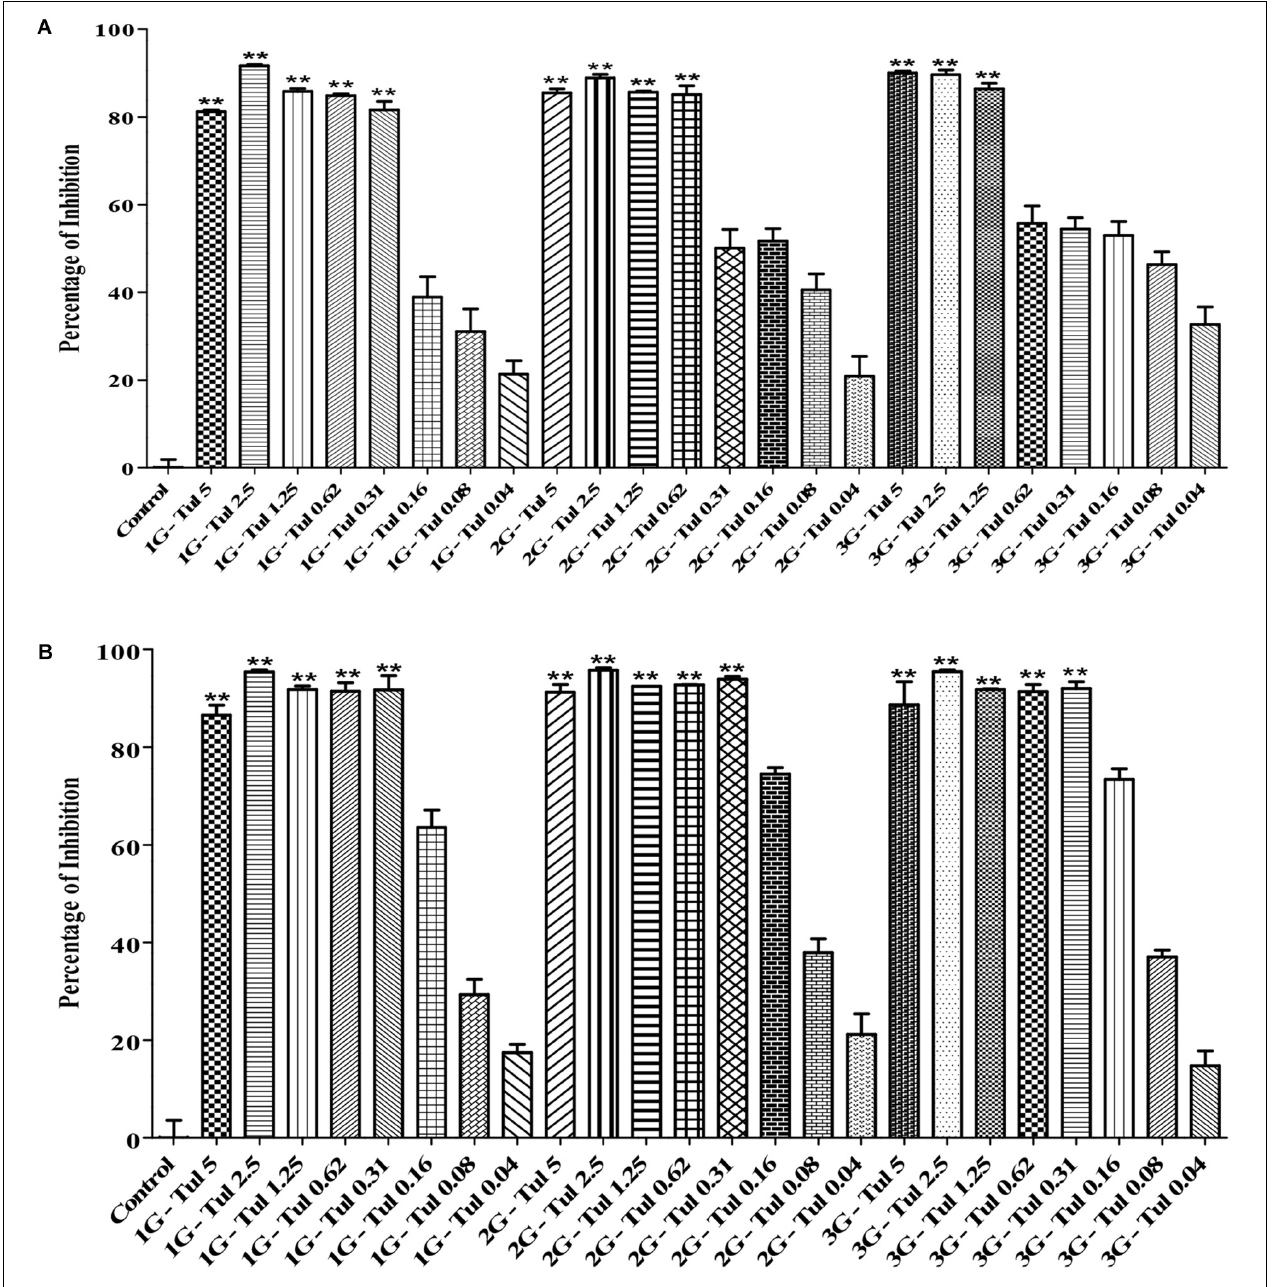
FIGURE 3 | Determination of the MICs of tulathromycin against the 1G, 2G and 3G cells of M. haemolytica (A) and the 1G, 2G, and 3G cells of P. multocida (B) , which had been pre-exposed to tulathromycin at 1/2MIC concentration for one, two and three times, respectively. The concentration of tulathromycin was ranging from 0.04 to 5 µ g/mL. One way ANOVA t -test was used for statistical significance. ∗ P -value < 0.05, ∗∗ P -value < 0.01, and ∗∗∗ P -value < 0.001 are shown. Correlation coefficient ( r ) was calculated using Pearson’s correlation